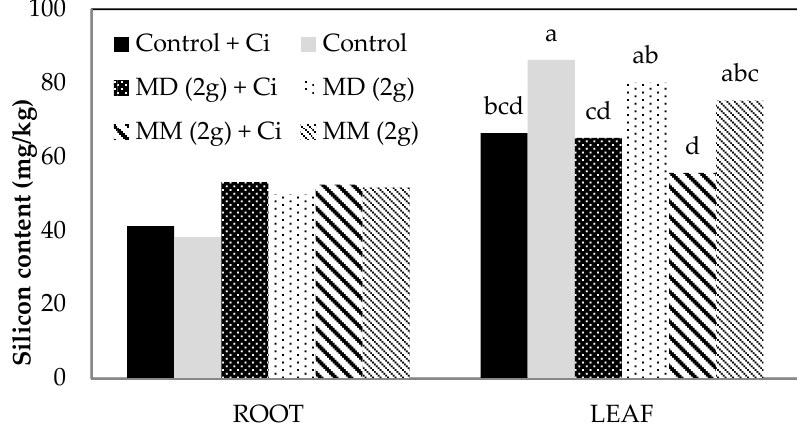
Figure 2. Silicon content (mg/kg) in dried root and leaf tissue four weeks after treatment with Mineral dust (MD) and Mineral mulch (MM), Experiment 2. Control plants received neither MD nor MM; MD (2 g), plants received 2 g MD in total; MM (2 g), plants received 2 g MM in total; control + Ci, MD (2 g) + Ci, MM (2 g) + Ci, plants inoculated with Ci; Root, No significant differences among treatments, ( p > 0.05, n = 6); Leaf, Bars labeled with the same letter are not significantly different ( p < 0.05, n = 6).